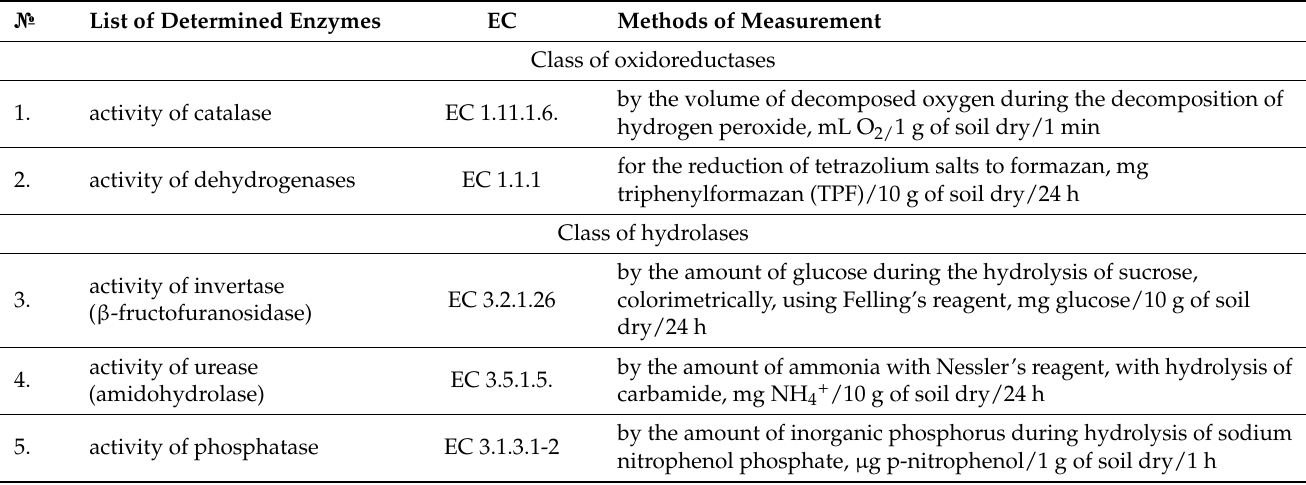
Table 1. Methods for studying the enzymatic activity of soils.